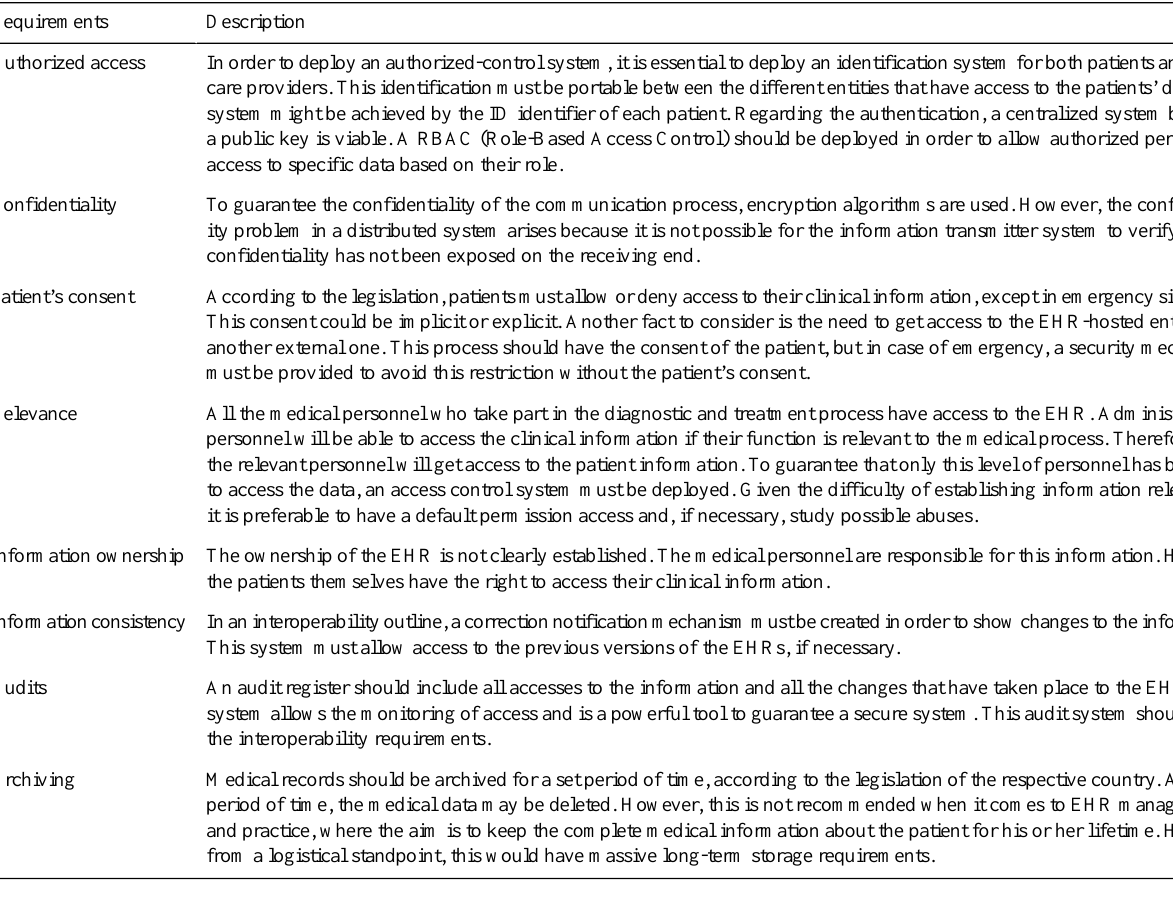
Table 1. Requirements for maintaining the security and privacy of an electronic health